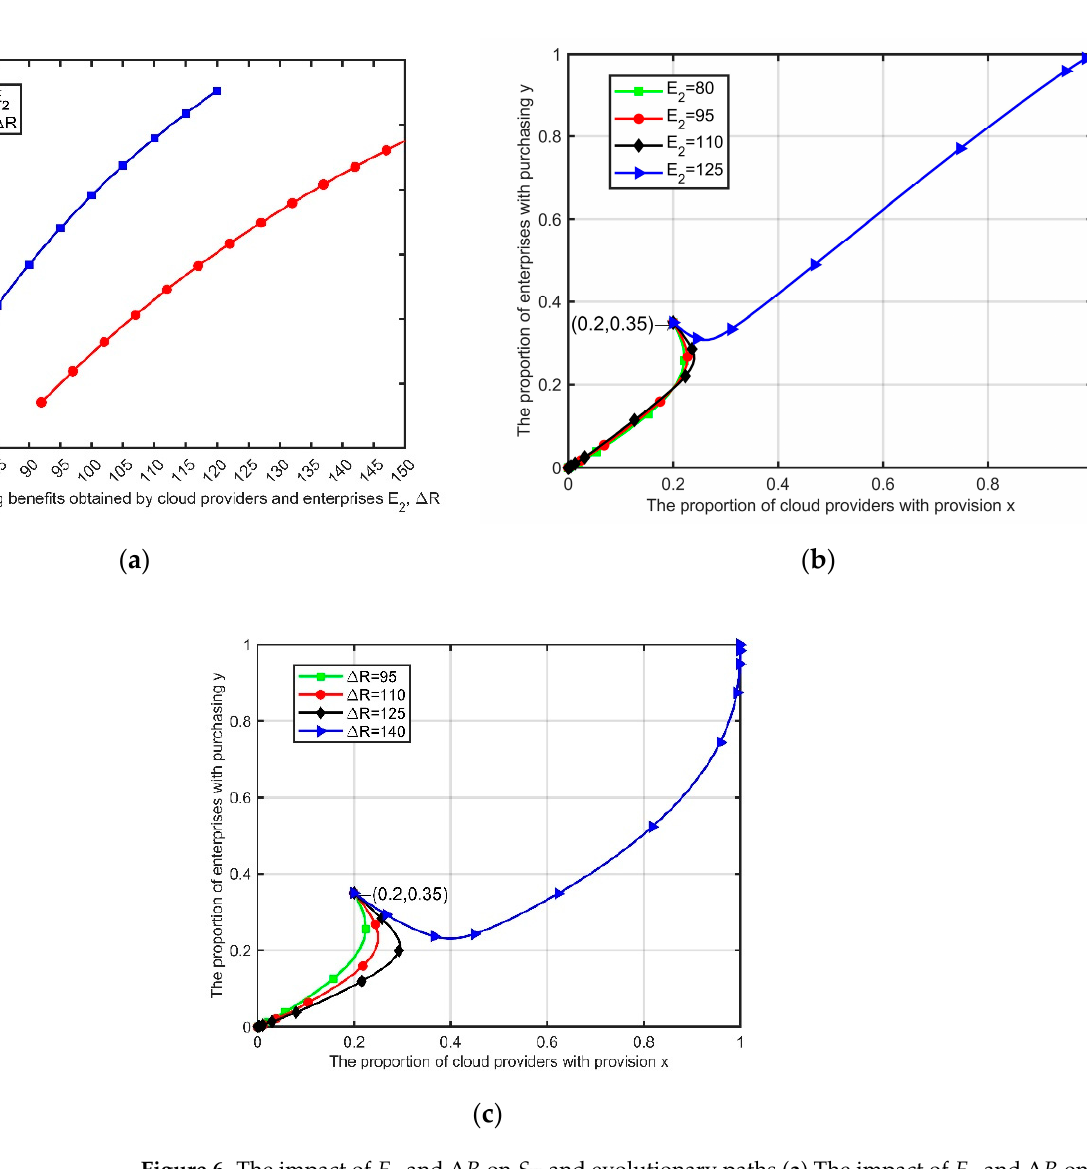
E ; (c) The evolutionary 2